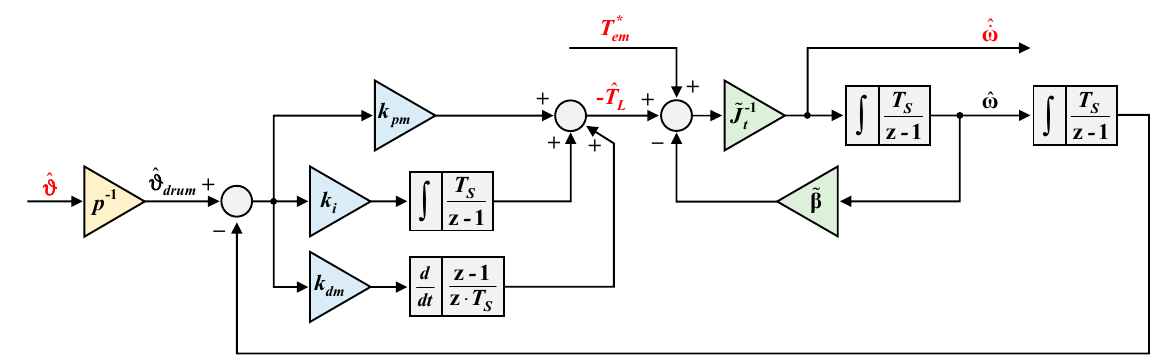
Figure 9. Block diagram of the modified position-tracking observer (MPTO).